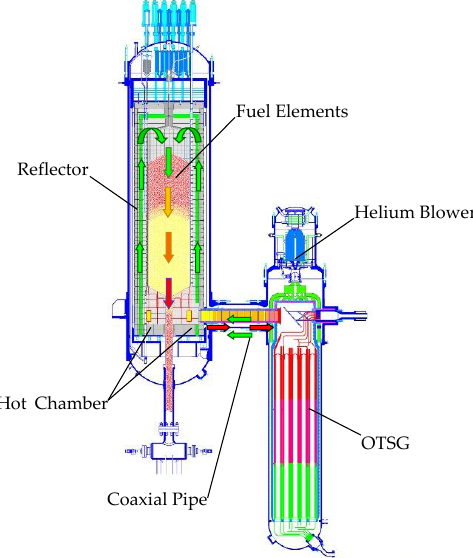
Figure 2. Schematic diagram of the Nuclear Steam Supply System (NSSS) of High Temperature Gas-cooled Reactor Pebble-bed Module (HTR-PM) plant.